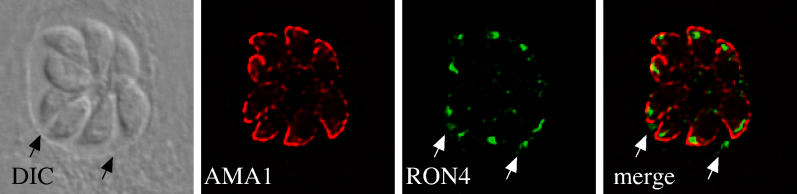
Localization of RON4 and TgAMA1 in Intracellular TachyzoitesDIC and deconvolution processing of IIF were used to image a PV containing eight intracellular parasites that had been fixed with formaldehyde and permeabilized with triton X-100. TgAMA1 was localized with mAb CL22 and Texas-red-conjugated goat-anti-mouse antiserum. RON4 was localized via rabbit antiserum to recombinant RON4 followed by goat-anti-rabbit antiserum conjugated with fluorescein isothyocyante (FITC) (green). The images shown represent an extended focus projection through five 0.1-μm sections after iterative deconvolution. RON4 staining within the vacuole in the regions between the parasites is indicated with an arrow.